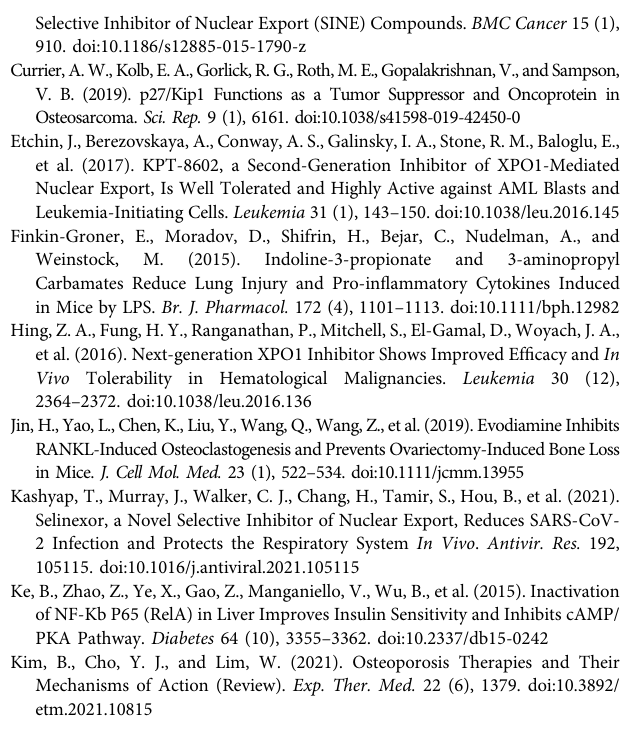
Supplementary Figure S1 | Elt has no obvious toxic effect on the liver or kidney in ovariectomized mice. Representative images of hematoxylin-eosin staining of the liver and kidney; n = 3